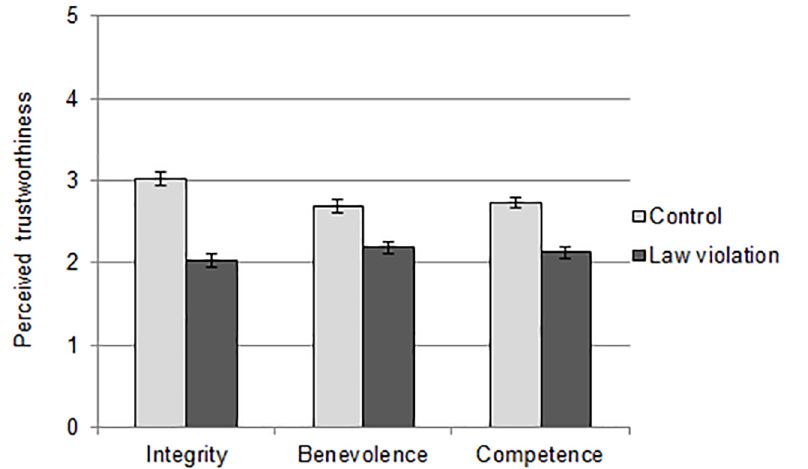
Figure 1. Interaction effect of the experimental condition on the perceived trustworthiness of a specific politician in Study